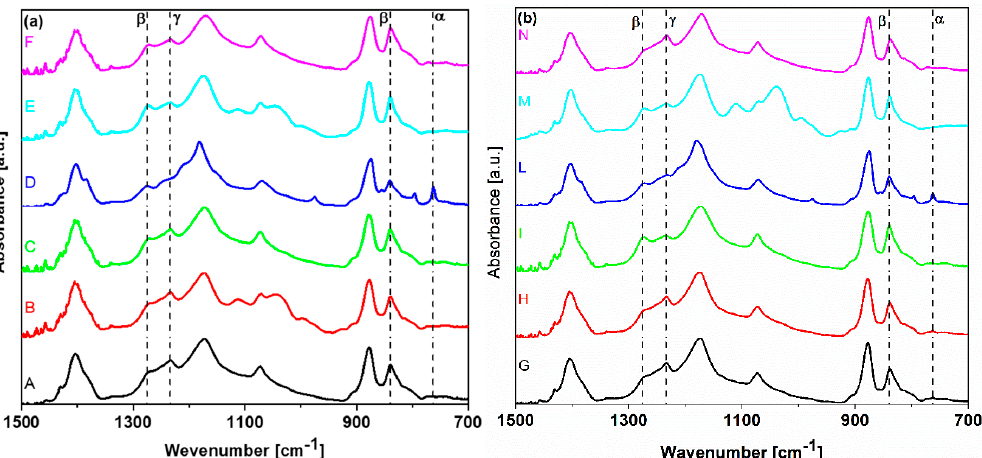
Figure 4. FT-IR spectra of 12 PVDF solutions.